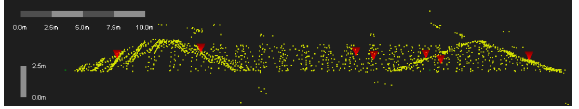
Figure 9: 3D Extracted roofs along with buildings footprints from pre-existing digital